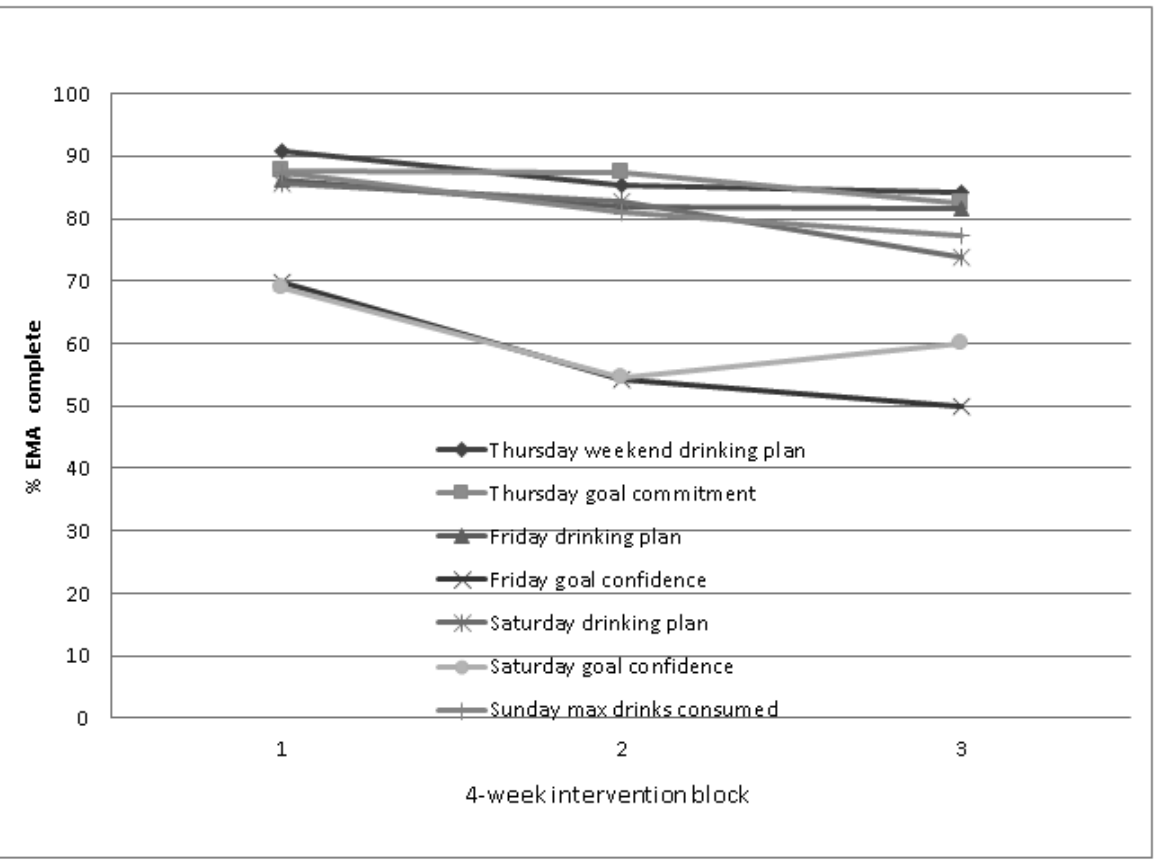
Figure 2. Ecological momentary assessment (EMA) completion rates by intervention block (TRAC2, Texting to Reduce Alcohol Consumption 2; CIs and/or standard errors are not included to allow for